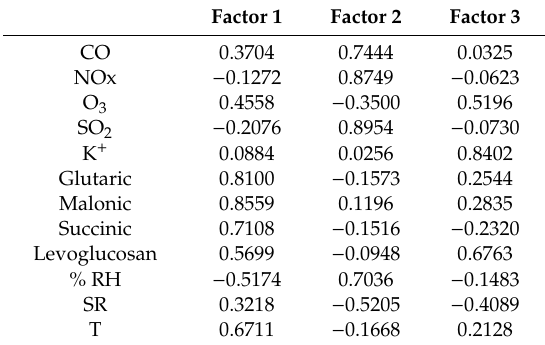
Table 8. Factor analysis with Varimax rotation realized for the Centro